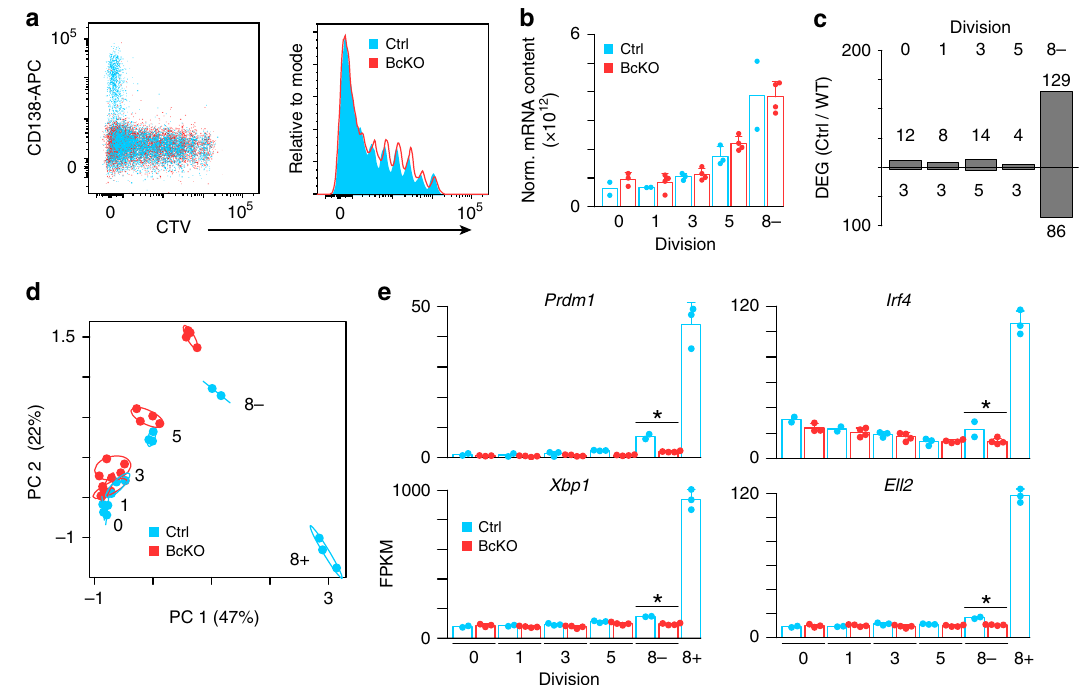
Fig. 3 BLIMP-1-dependent transcriptional reprogramming is defective in division 8. ( a ) Representative fl ow cytometry analysis of Prdm1 fl / fl (Ctrl) and Cd19 Cre/ + Prdm1 fl / fl (BcKO) B cells 72 h after LPS inoculation. ( b ) ERCC normalized total mRNA content for samples from the indicated divisions sorted from ( a ). c Bar plot showing the number of differentially expressed genes (DEG) for the indicated division between Ctrl and BcKO B cells. d Principal component analysis of samples from ( b ) using all DEG. The location of cells in each division is labeled. Circles denote 99% con fi dence intervals for samples in each division. e Bar plot of expression of select genes from divisions 0, 1, 3, 5, 8 – and for Ctrl 8 + . FPKM fragments per kilobase per million. Data in ( b , e ) represent mean ± SD and asterisk indicates statistical signi fi cance (FDR < 0.05) as determined by edgeR 59 . Data were derived from 2 to 4 individual mice as follows: Ctrl division 0 ( n = 2), 1 ( n = 2), 3 ( n = 3), 5 ( n = 3), 8 − ( n = 2), and 8 + ( n = 3); BcKO division 0 ( n = 3), 1 ( n = 4), 3 ( n = 4), 5 ( n = 4), 8 − ( n = 4). Source data are provided as a Source Data fi